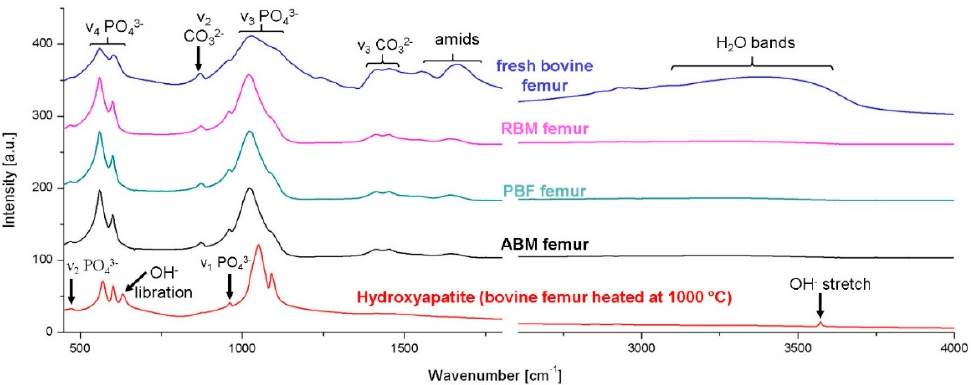
Figure A2. FTIR spectra from top to bottom of: fresh bovine femur (Greiner et al., 2019) [40], RBM femur, PBF femur, ABM femur, and bovine femur heated at 1000 ◦ C (and subsequently measured at room temperature) which serves as a HAp reference (Greiner et al., 2019 [40]). Fresh bovine, RBM, PBF, and ABM femur spectra show carbonate absorption bands and an absence of both, the OH − libration and the OH − stretching band, while the HAp standard shows absence of carbonate bands and presence of OH − libration and stretching bands. This verifies that t mineral component is not hydroxylapatite but rather carbonated